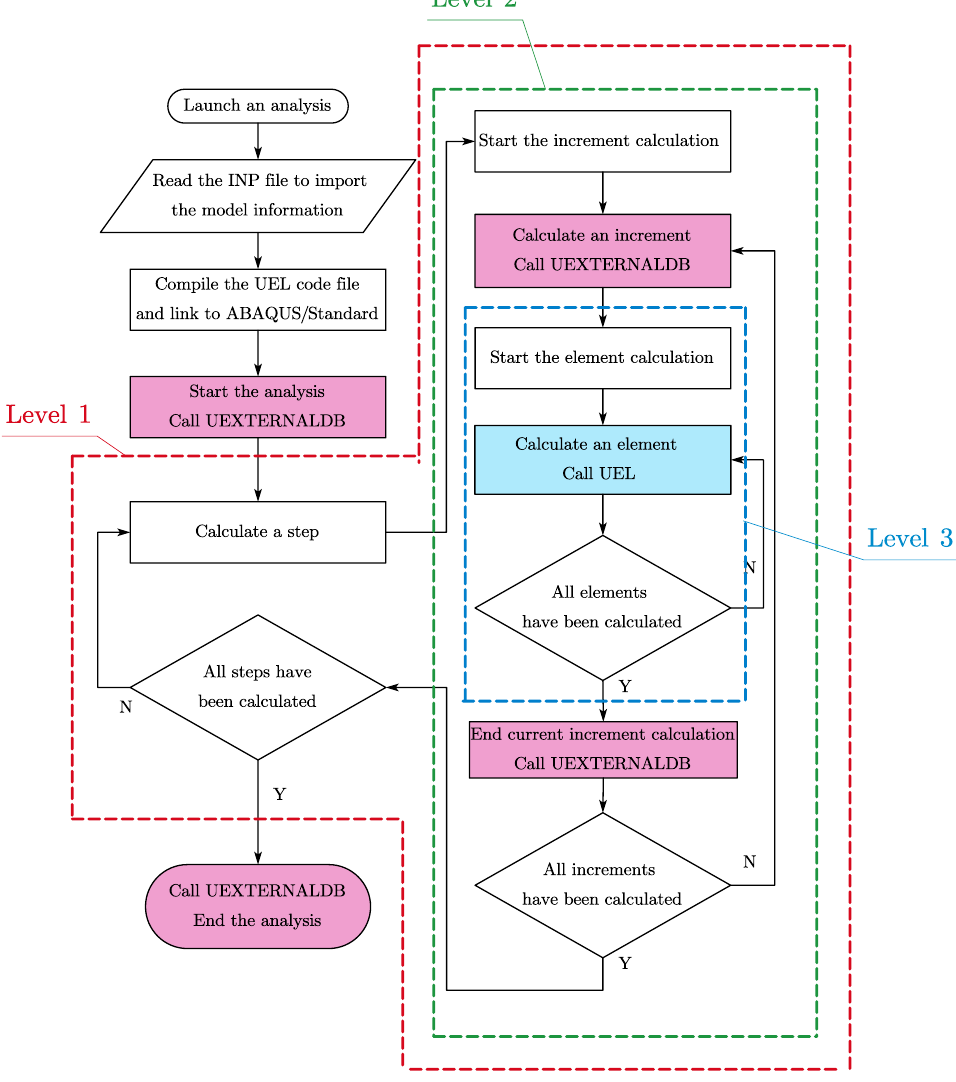
Figure 8. Hierarchy of the calculation process of